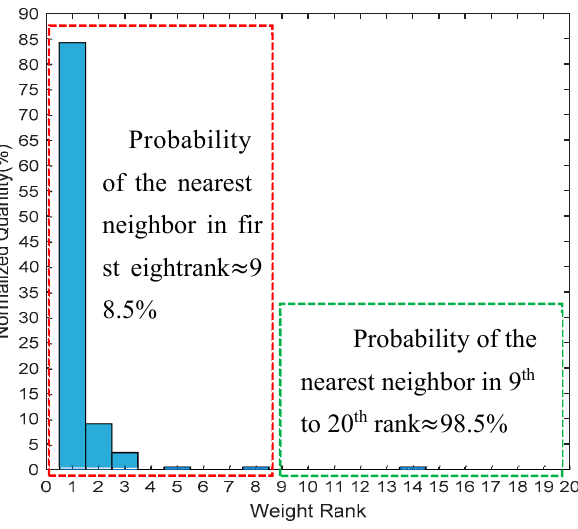
Figure 7. Weight rank evaluation of real nearest pattern.